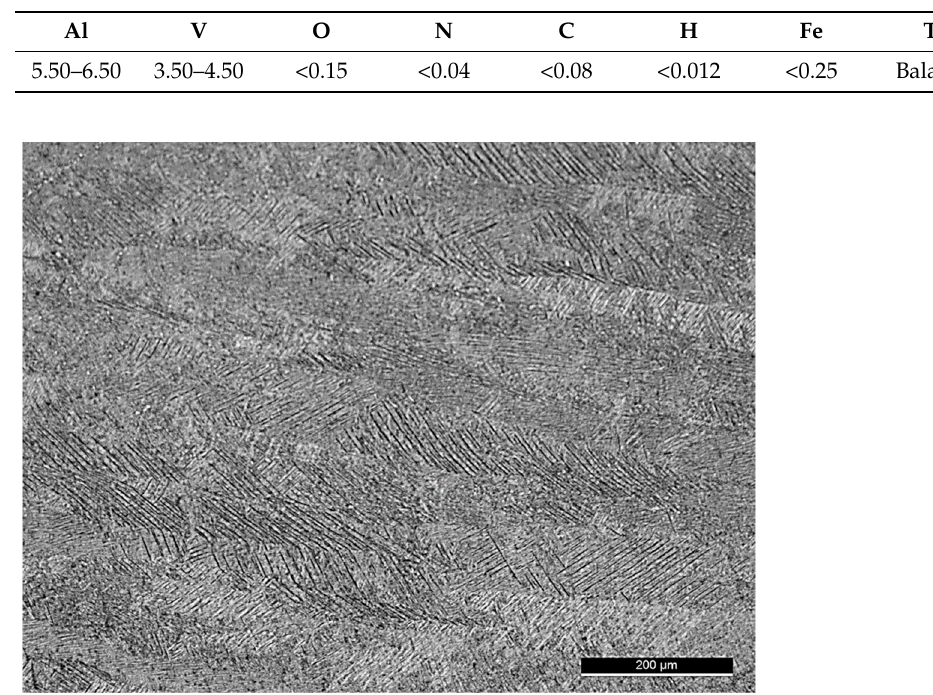
Figure 1. Microstructure of the specimens.